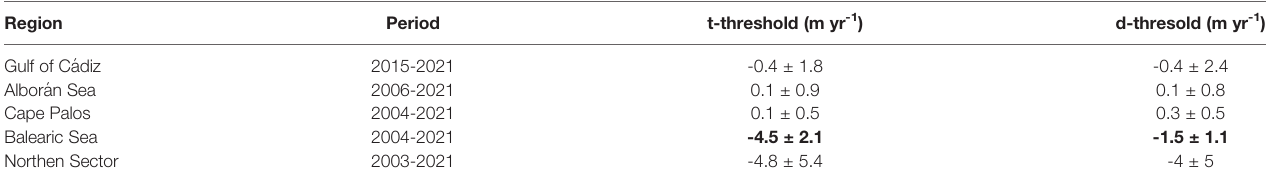
Bold numbers indicate those results that are statistically signi fi